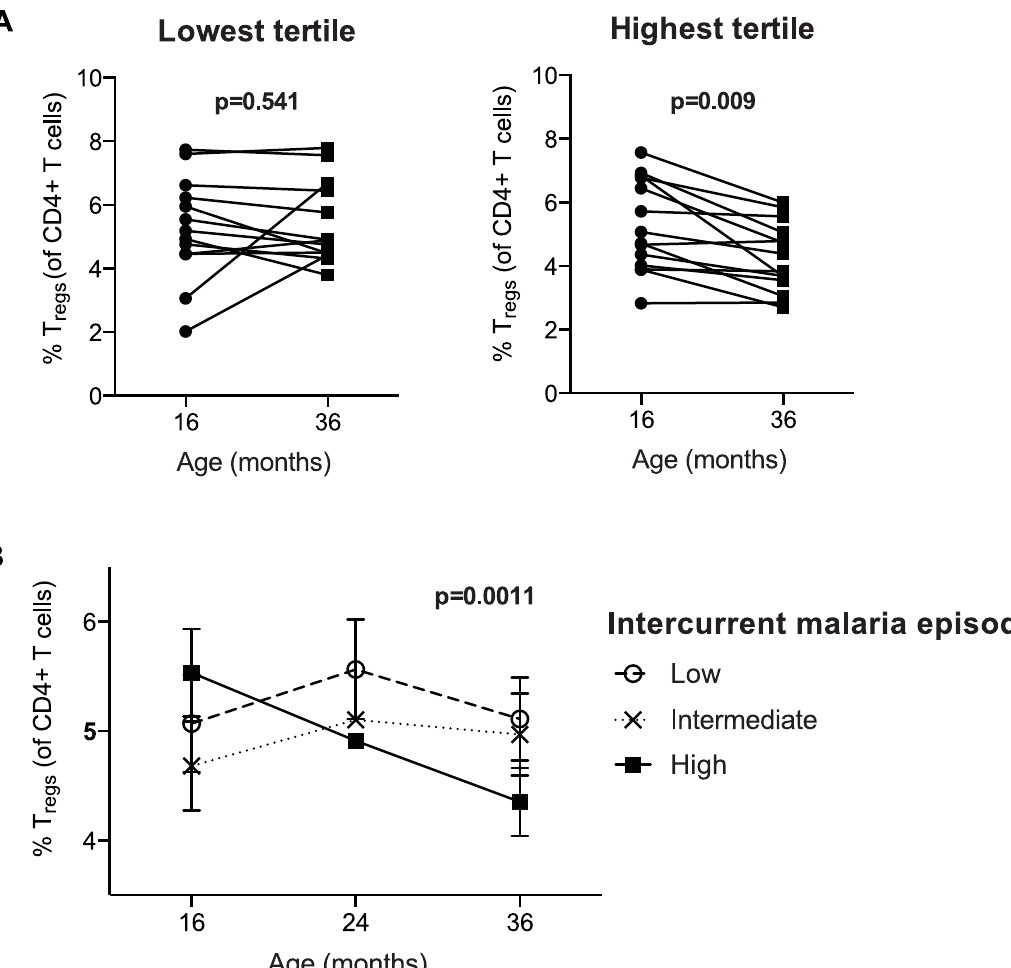
Fig 2. Regulatory T cells decrease over time in individuals with high but not low malaria incidence. T reg frequencies of CD4+ T cells (FoxP3+CD25 +CD127 dim ) were measured at 16, 24 and 36 months of age (PROMOTE- SP arm). (A) Children were divided into tertiles based on incidence of malaria between 16 and 36 months; lowest tertile median incidence 4.0 episodes ppy (IQR 3.0 – 5.5); intermediate tertile median incidence 8.2 episodes ppy (IQR 7.3 – 9.2); highest tertile median incidence 13.7 episodes ppy (IQR 10.3 – 14.6). The median duration since last malaria infection in these three tertiles was 8.5, 20, and 100 days, respectively. Wilcoxon matched pairs signed rank test p values indicated. Between 16 and 36 months, T reg frequencies declined in individuals in the highest but not lowest tertile of malaria incidence. (B) Changes in T reg frequencies between 16, 24 and 36 months were compared between children in the lowest, intermediate, and highest tertiles of malaria exposure by generalized estimate equations, accounting for repeated measures, age, duration since last malaria episode and parasite status at time of sampling.